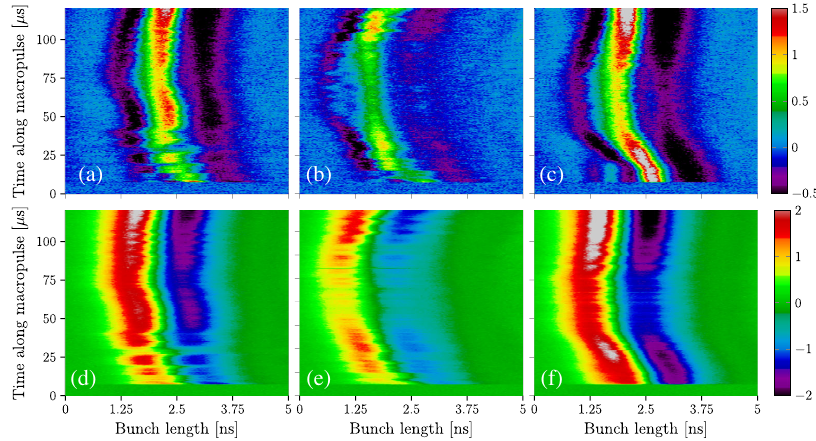
FIG. 18. Bunch length measurement for three consecutive macropulses by GTR (top row) and pickup (bottom